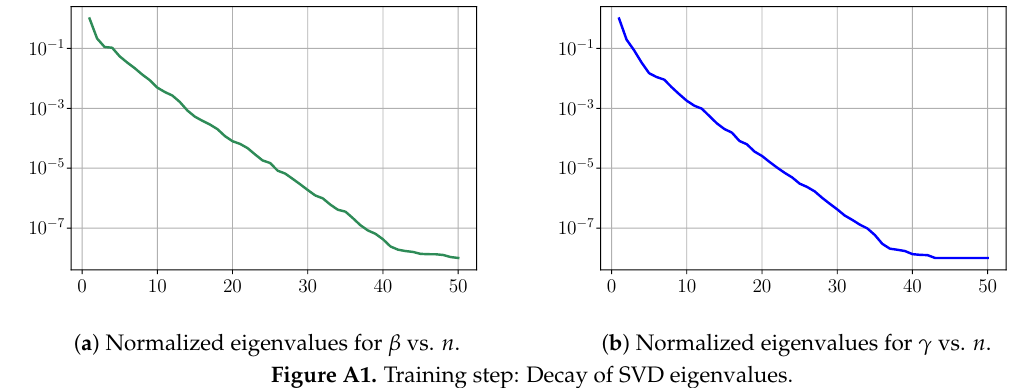
( b ) Normalized eigenvalues for γ vs. n . Figure A1. Training step: Decay of SVD eigenvalues.